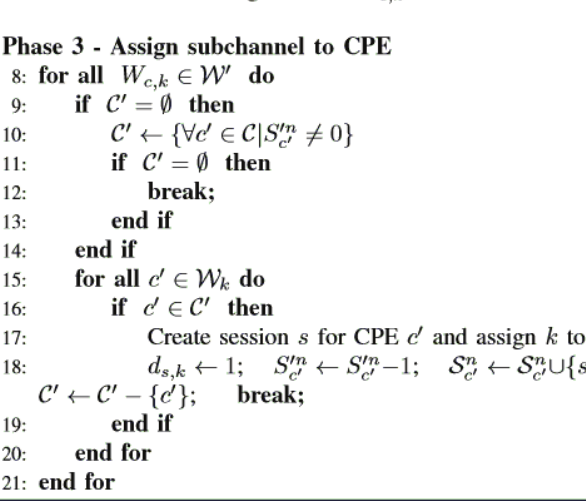
Figure 3. Greedy subchannel assignment.